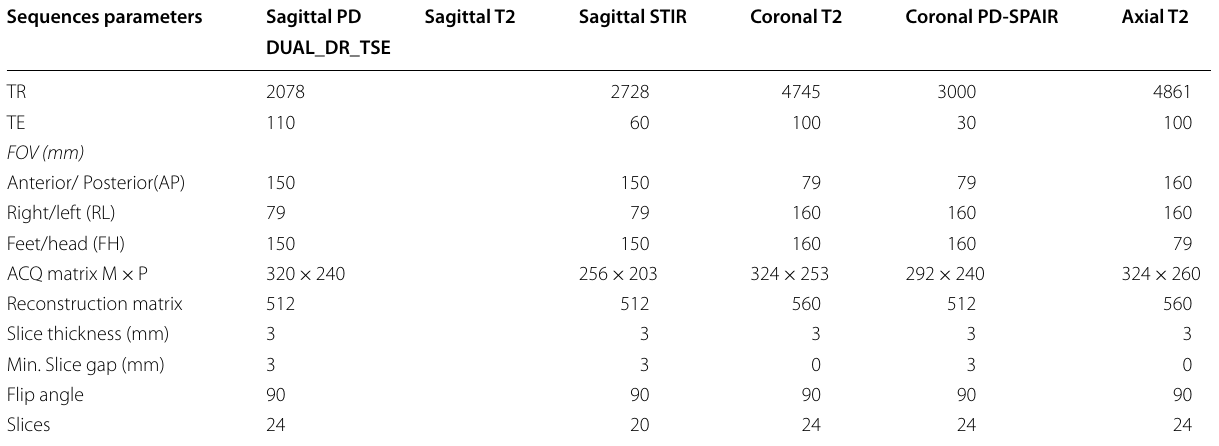
TR, Repetition time; TE, echo time; FOV, field of view (ranged from 15 to 16 cm); DUAL_DR_TSE, double PD and T2 weighted sequences The average duration time of the examination was from 25 up to 30 min